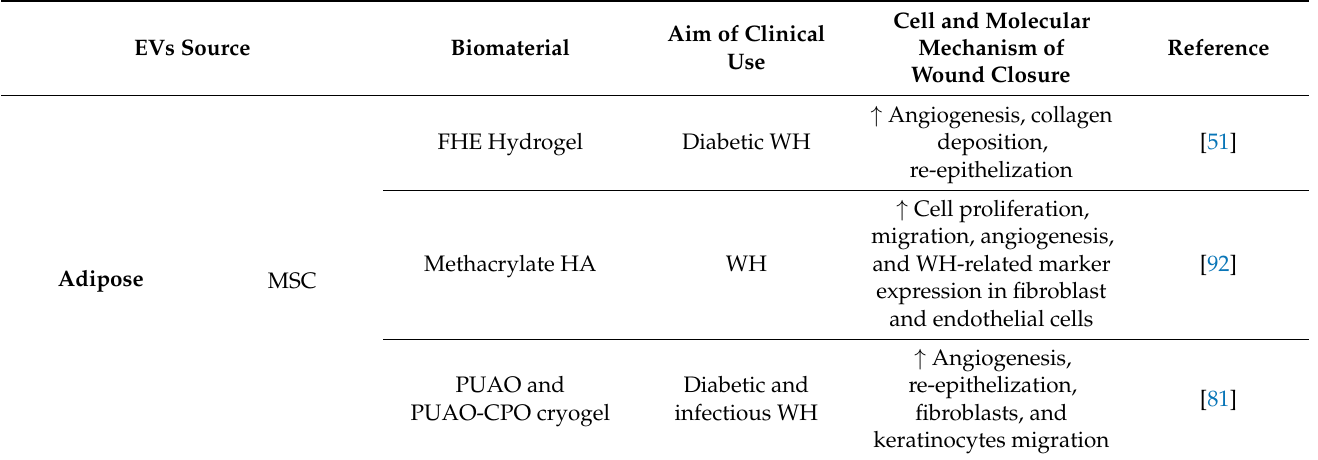
Table 1. Studies employing EV-based biomaterials for wound healing